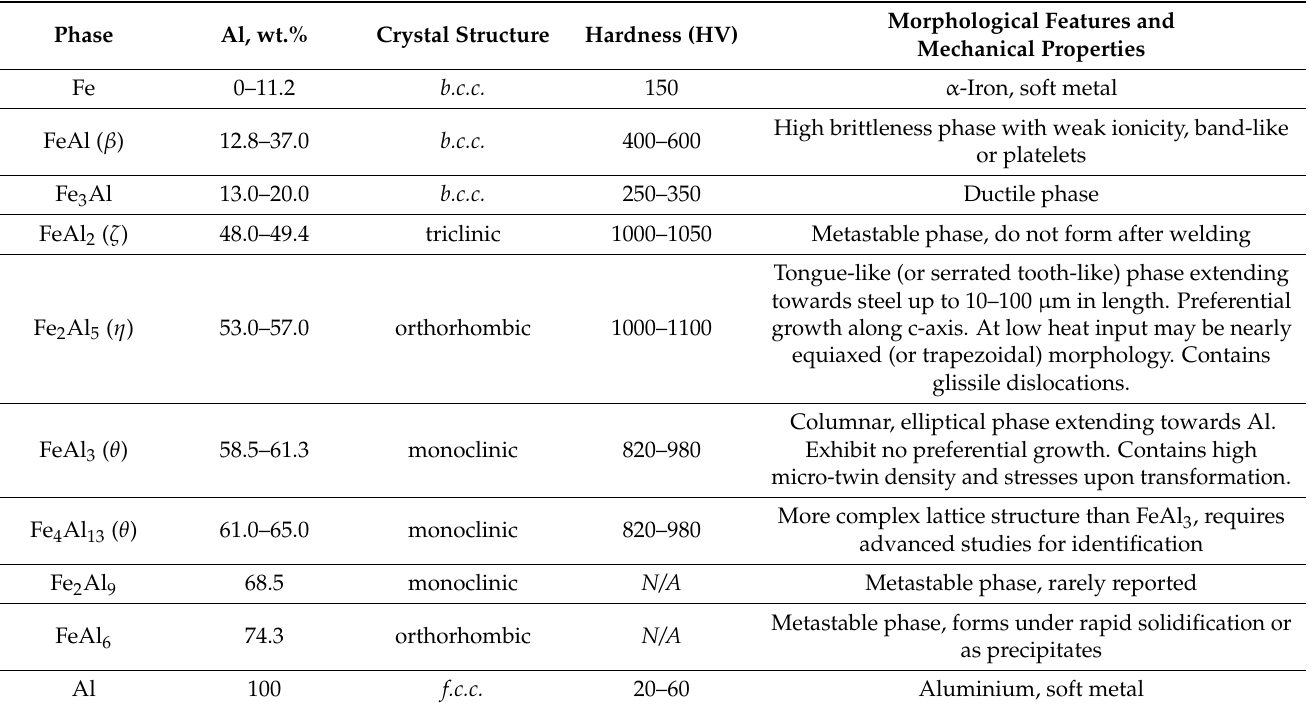
Table 2. Characteristics of different Fe x Al y phases [5,73,83,94–97]. The visual representation of the crystal structure can be found in [98]. Hardness values may vary significantly depending on parent metal used. Composition of Al (in wt.%) varies depending on